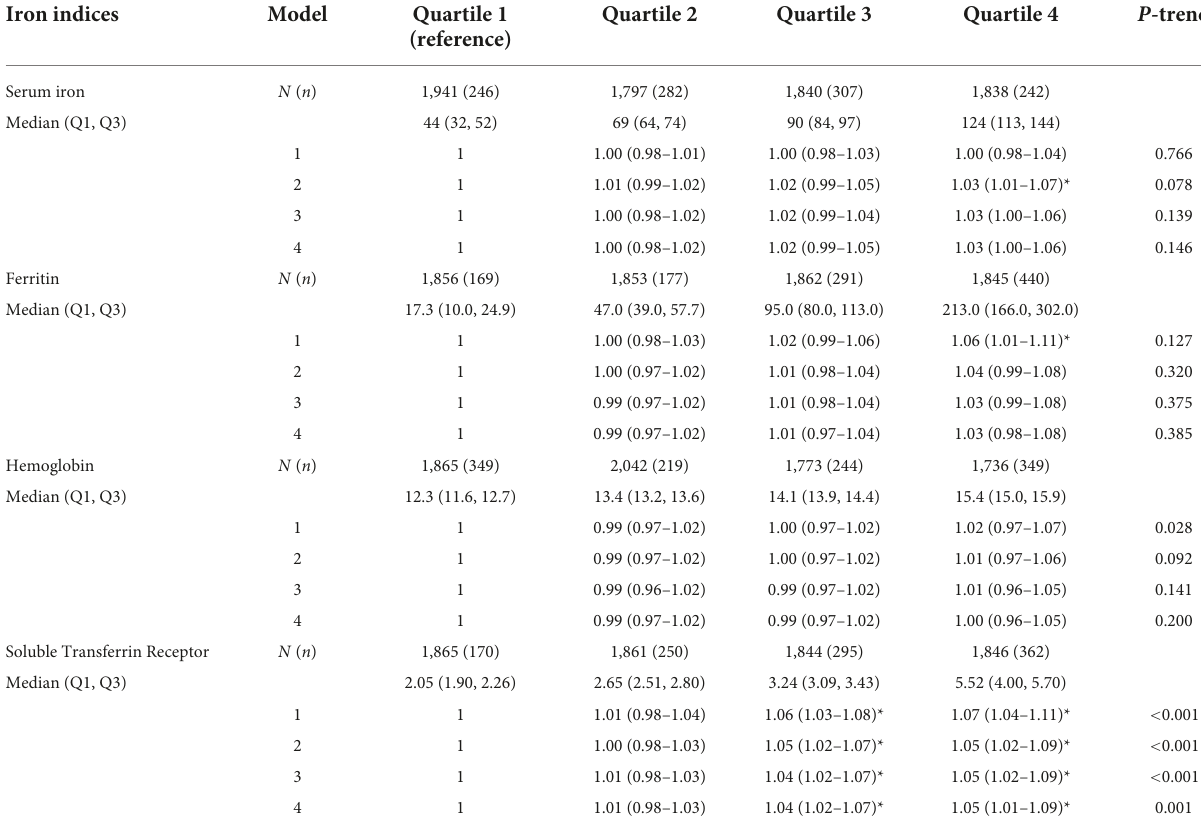
TABLE 2 Association between markers of iron metabolism (as quartile) and hypertension in National Health and Nutrition Examination Survey (NHANES) 2007–2010 and NHANES